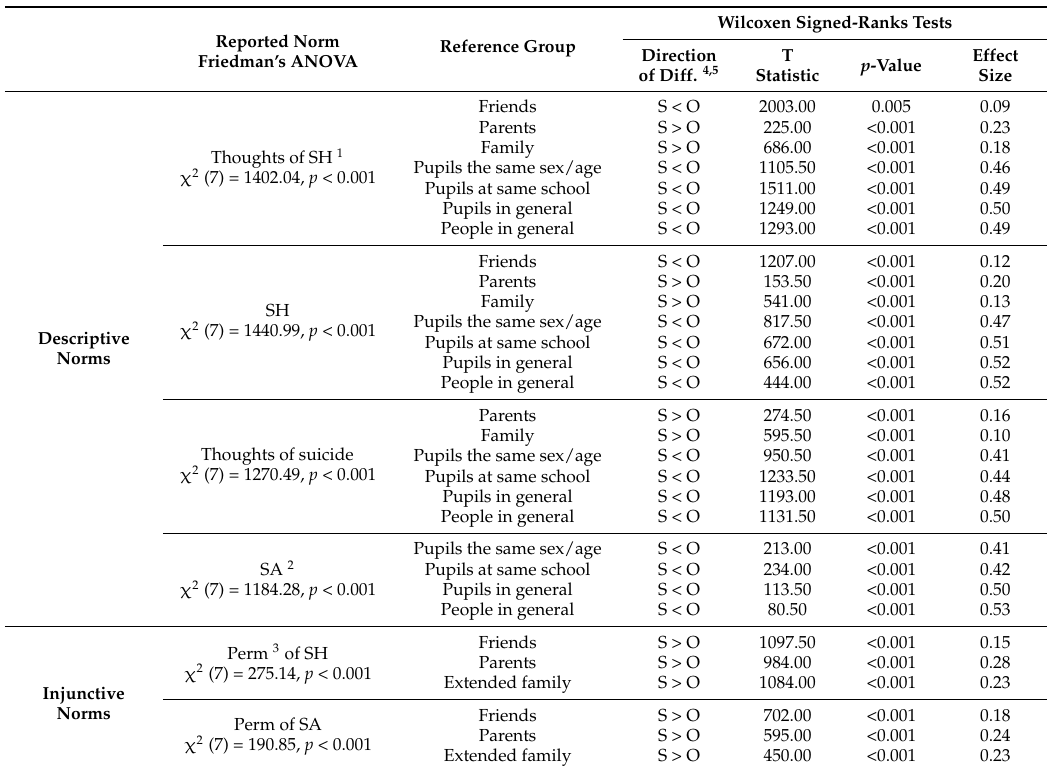
Table 2. Results of Friedman’s ANOVA with post-hoc Wilcoxen signed-ranks to determine difference between perceived and reported